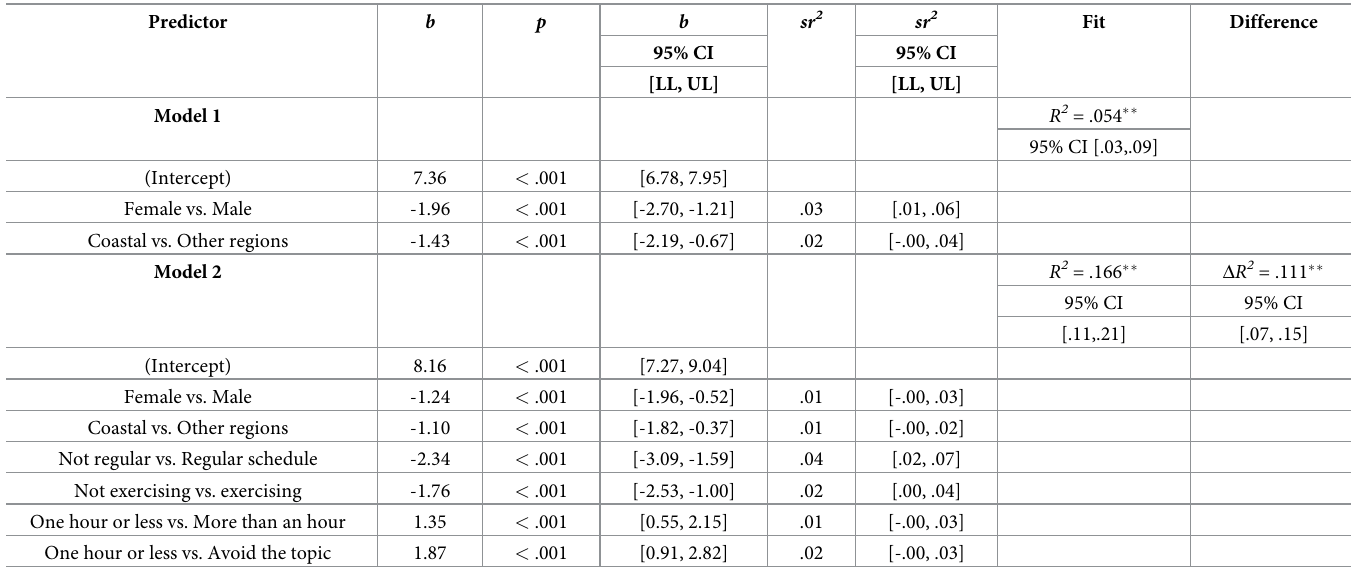
Table 4. Hierarchical linear regression analysis (unstandardized regression coefficients) for variables predicting PHQ-9 total sum scores. Predictor b